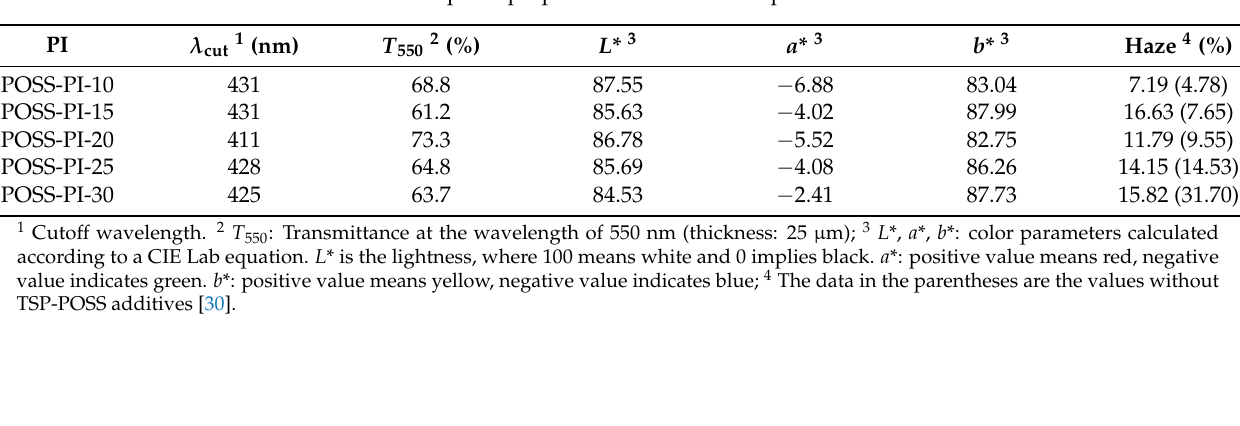
Figure 5. XRD patterns of POSS-PI composite films.